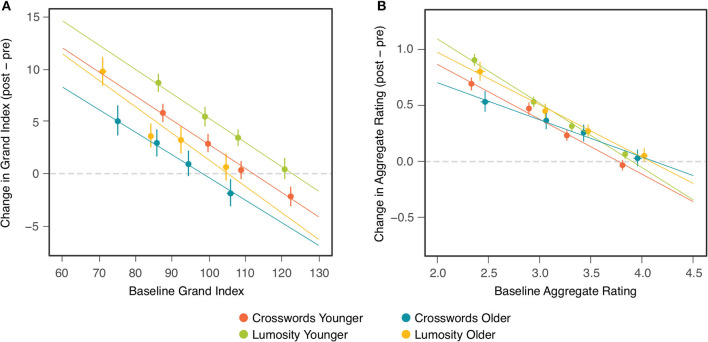
Change (post-pre) in NCPT Grand Index (A) and Aggregate Survey Rating (B) as a function of baseline assessment. Each panel includes four colors corresponding, respectively, to each combination of age cohort and training group. Within each combination, markers indicate the means of participants in quartile bins. Bars indicate 95% confidence intervals of the means. Lines show the fits of linear regression to the points for individual participants in each of the four combinations.